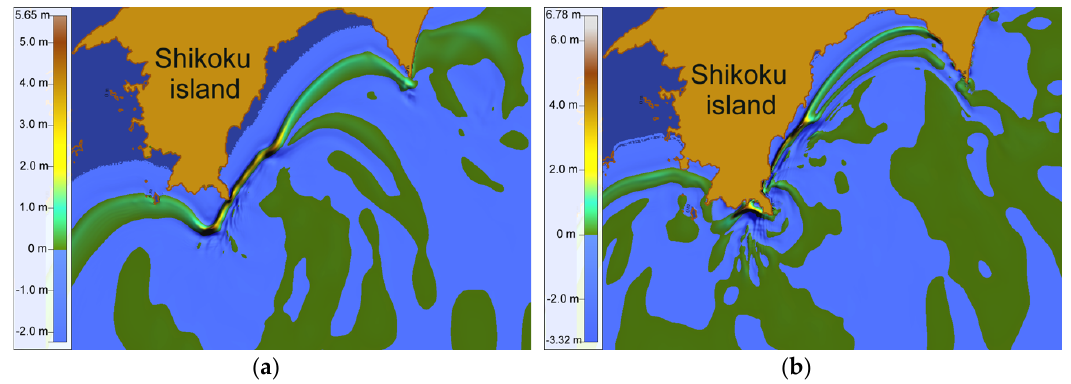
Figure 7. Calculated tsunami heights near the southwest of Shikoku Island 1500 s ( a ) and 2000 s ( b ) after the start of propagation. In the left part of each picture, the color legend is presented.